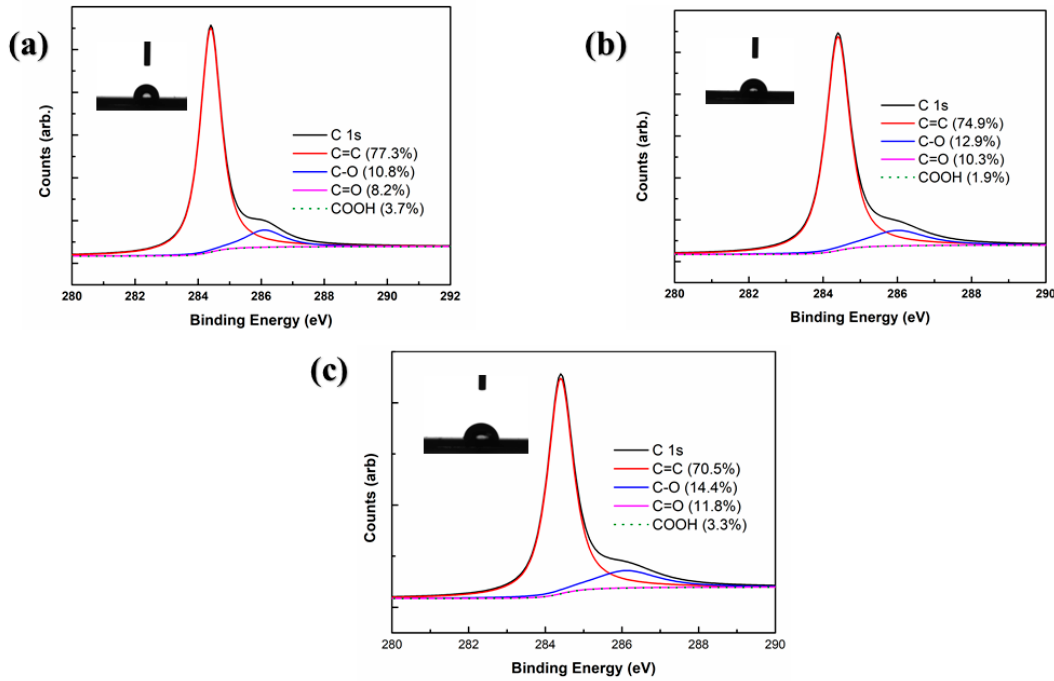
Figure 6. XPS of ( a ) graphene grown on copper foil pre-treated by AA; ( b ) graphene grown on copper foil pre-treated by AP; ( c ) graphene grown on pristine copper foil.